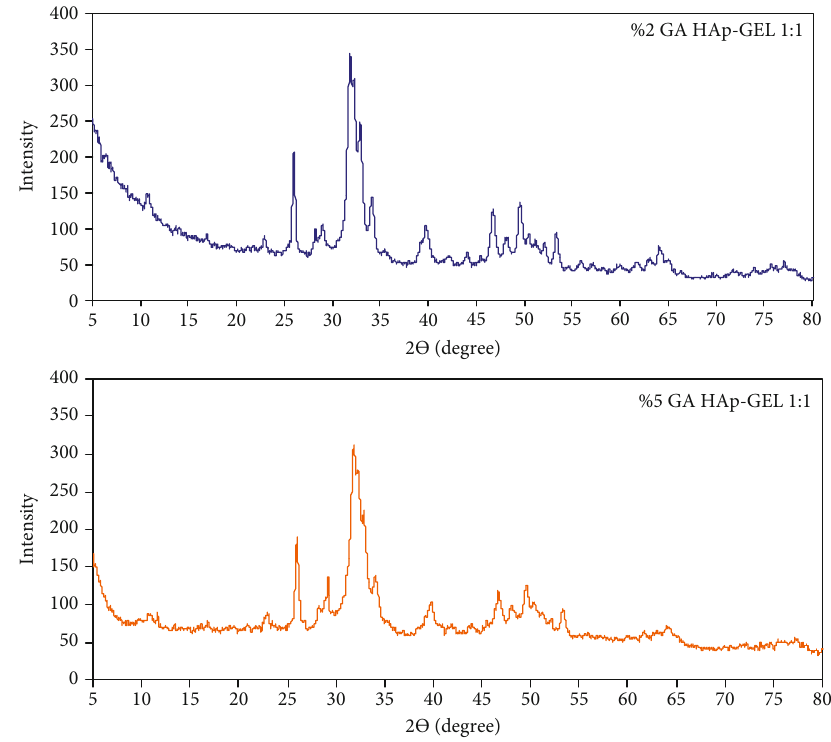
Figure 2: XRD patterns of the HAp-GEL composites cross-linked with di ff erent amounts of